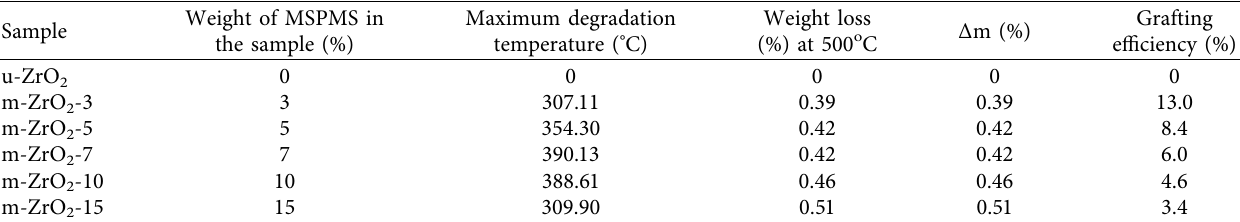
2 nanoparticles. 2